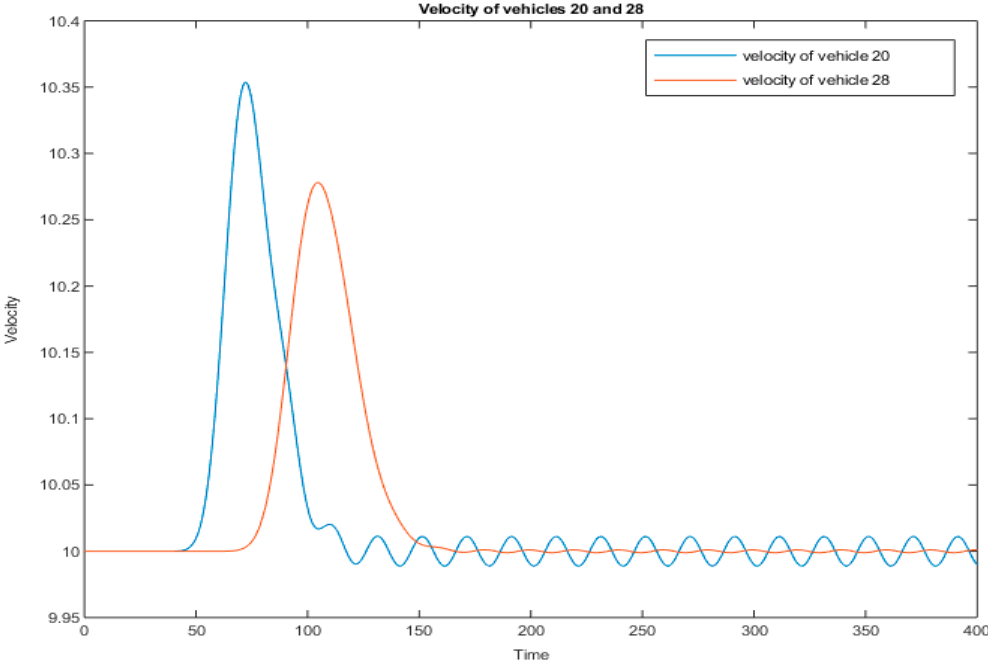
Figure 7. The velocity of vehicles 20 and 28 plotted versus time. The amplitude scale has been magnified in respect of Figure 6, to better appreciate the arrival (peak) of the harmonic disturbance imparted to the leader.